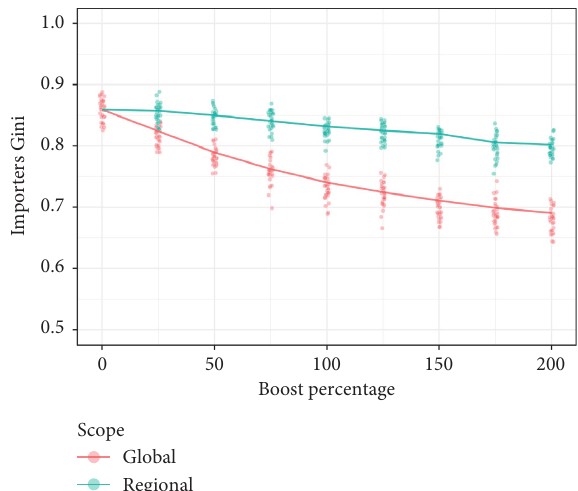
Figure 5: Effect of the improvement policy for year 2005. The policy is applied to the lower 2% of global trade. Dots are the results of individual experiments. Solid lines join the average values for each boost percentage.